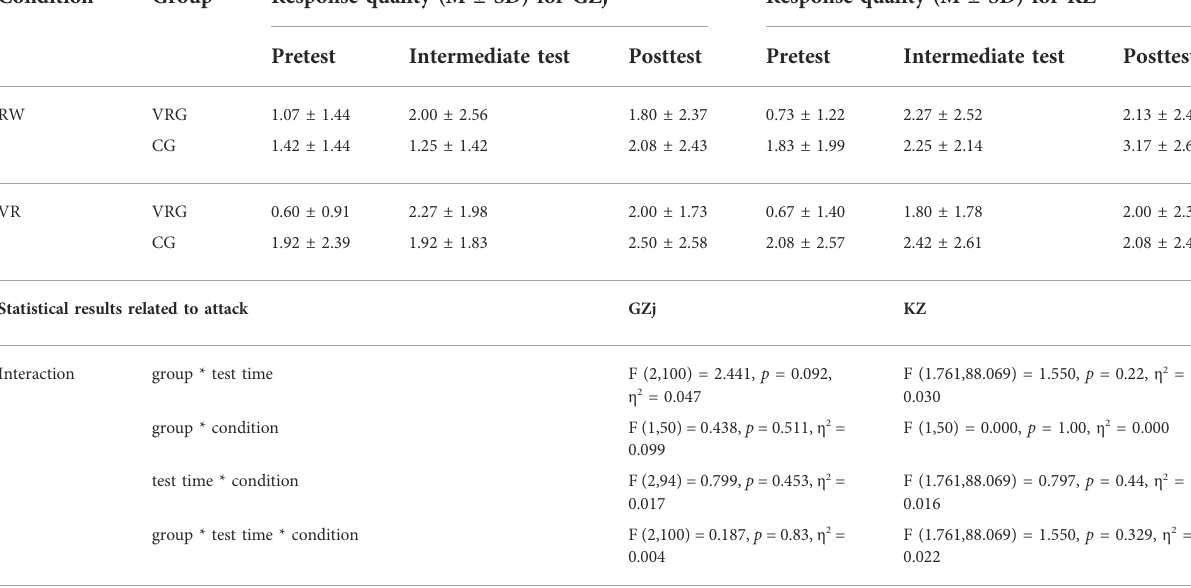
TABLE 3 Results for “ response quality ” for each attack (GZj, KZ), for each test time (pretest, intermediate test, posttest), for each condition (RW, VR), and for each group (VRG, CG). A higher value represents a better “ response quality ” (maximum = 8) towards the attack of the opponent.